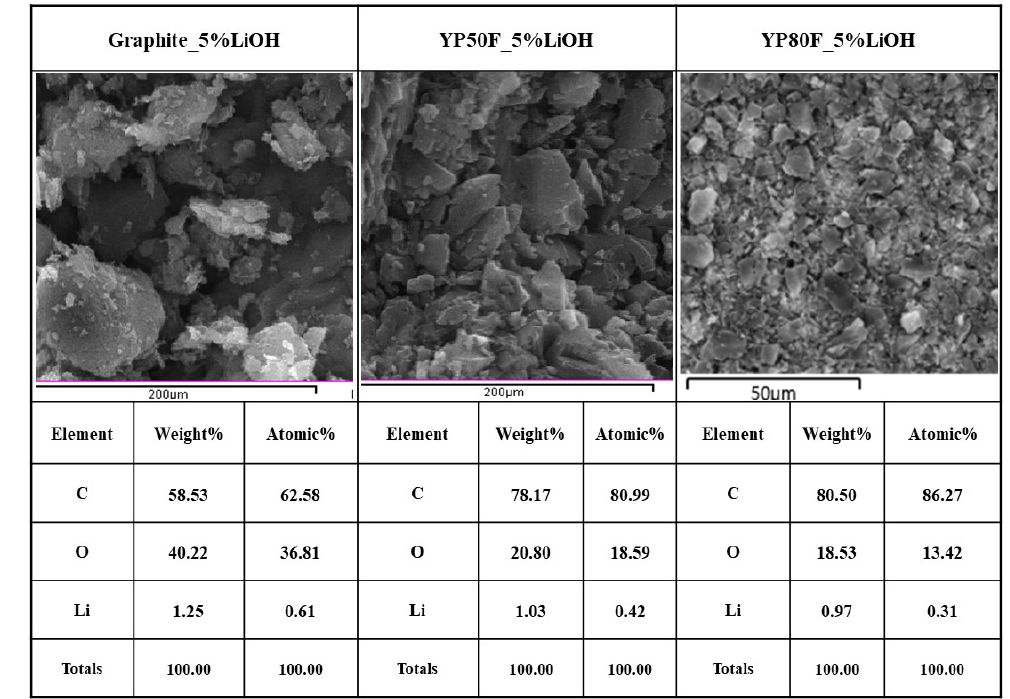
Figure 3. EDAX analysis of LiOH-treated YP50F, YP80F and graphite. Table 1. Surface functional group analysis of the LiOH-treated carbon